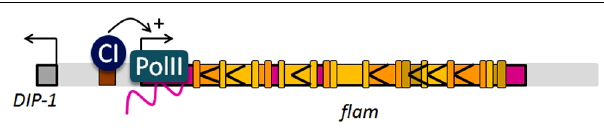
FIGURE 3 | Molecular structure of the flam locus. The CI binding site, the transcription start site and the strong biased orientation ofTEs indicated by arrows are